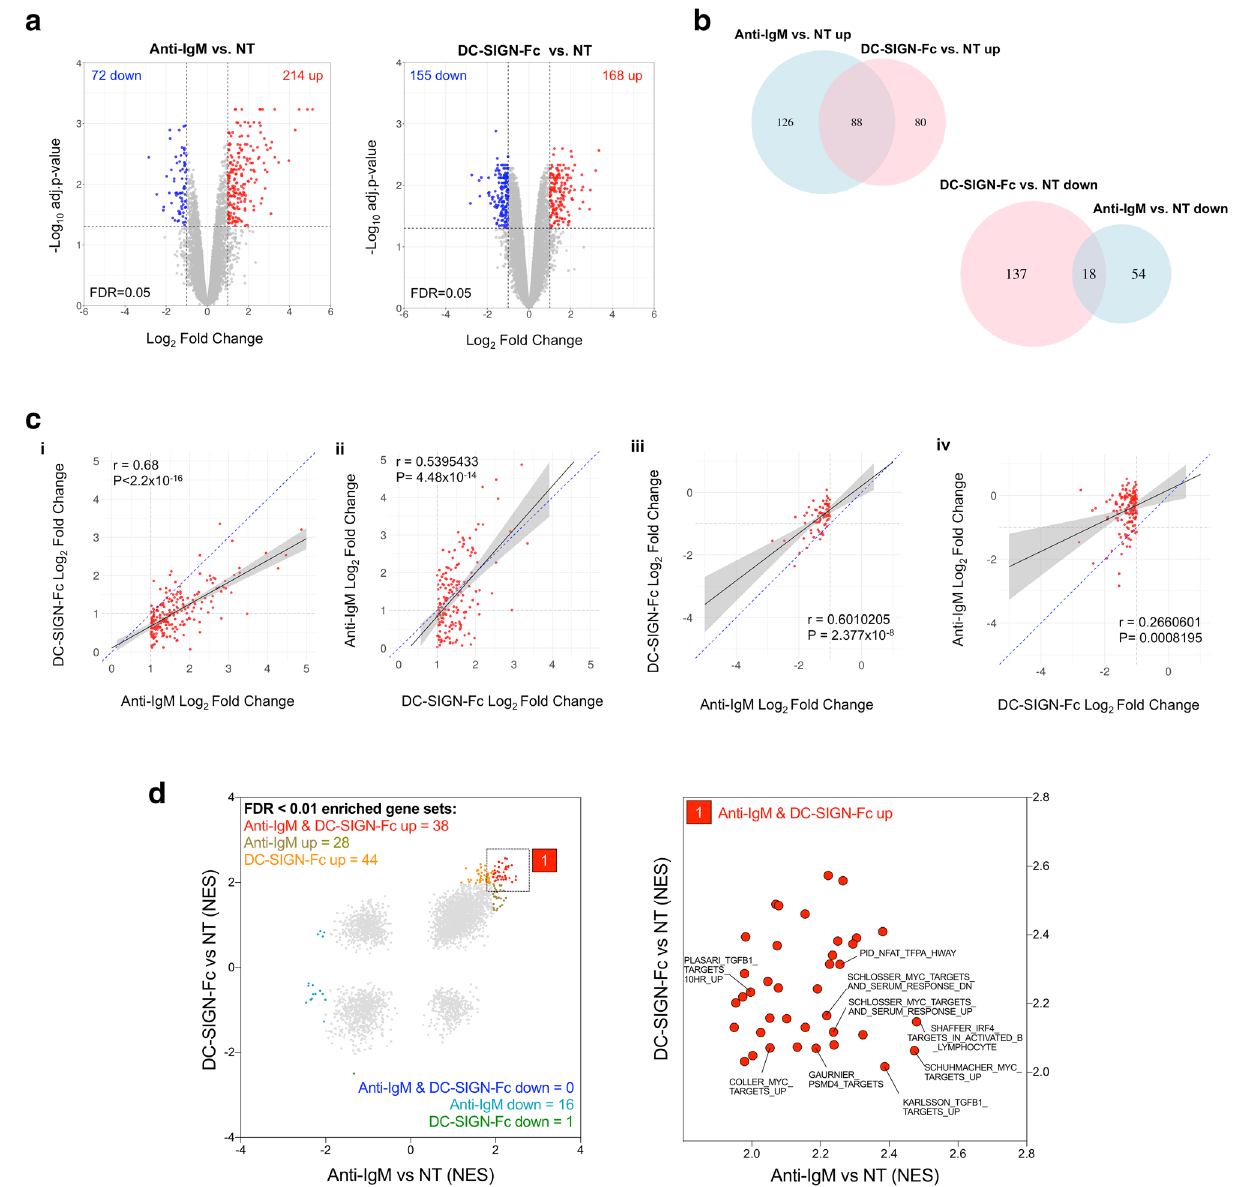
Figure 1. Effect of DC-SIGN on gene expression in primary FL samples. ( a – d ) RNA-seq analysis in FL samples FL-B536, FL-LY86 and FL-LY221 stimulated with anti-IgM or DC-SIGN-Fc. ( a ) Volcano plots showing effect of anti-IgM (left) or DC-SIGN-Fc (right) on gene expression in anti-IgM/DC-SIGN-Fc-treated vs. non treated (NT) cells. Genes considered to be significantly upregulated or downregulated (log 2 FC ≥ 1.0/ ≤ − 1.0, FDR Q ≤ 0.05) are colored red or blue, respectively. ( b ) Venn diagrams showing the degree of overlap between the anti-IgM and DC-SIGN-Fc upregulated (top panel) and downregulated (bottom panel) genes. ( c ) Graphs show effect of DC-SIGN-Fc on genes significantly (i) induced (log 2 FC ≥ 1.0, FDR Q ≤ 0.05) or (ii) repressed (log with 95% confidence interval (grey) fitted by linear regression between the log 2 FC datasets. The blue dotted line is a line of equality (x = y). Results of Pearson’s correlation analysis are shown. ( d ) Gene set enrichment analysis (GSEA). Left panel shows NES scores for all gene sets for anti-IgM or DC-SIGN-Fc-treated FL samples, with gene sets with enrichment FDR Q < 0.01 colored as indicated. Right panel is an expanded view of the region containing positively correlated gene sets with enrichment FDR Q < 0.01 1 for both anti-IgM and DC-SIGN-Fc with identity of selected pathways detailed. Full details of GSEA outputs are provided in Supplementary file 2